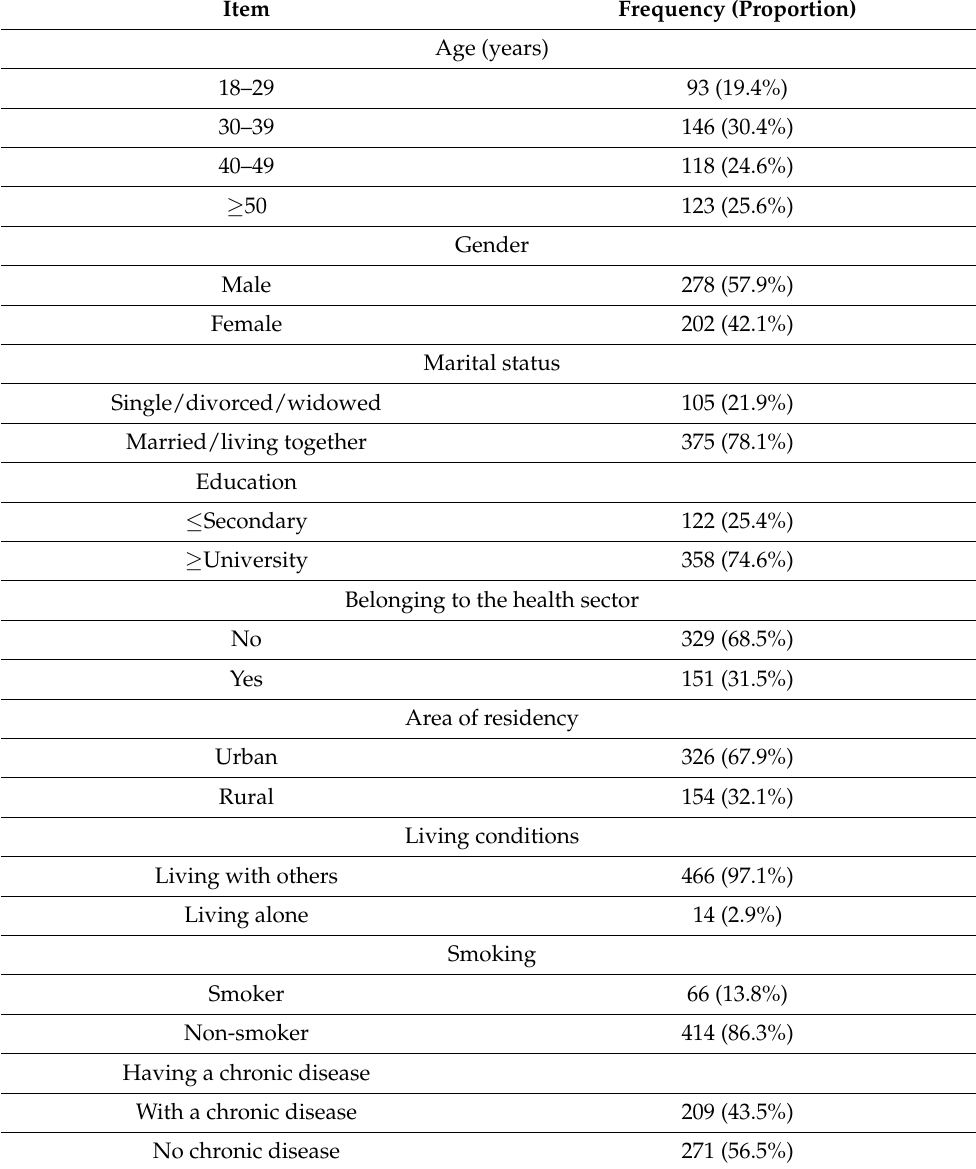
Table 1. Sociodemographic characteristics of a sample of 480 participants from Jazan, Saudi Arabia.